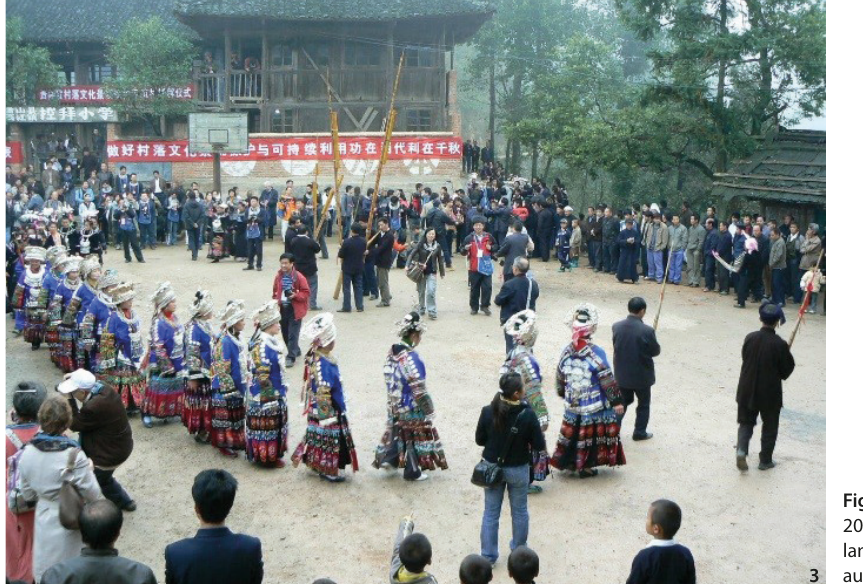
Figure 3 Kongbai Miao Village, Guizhou, 2008. Silversmithing village: space/place/ landscape setting relationship (Source: the author).